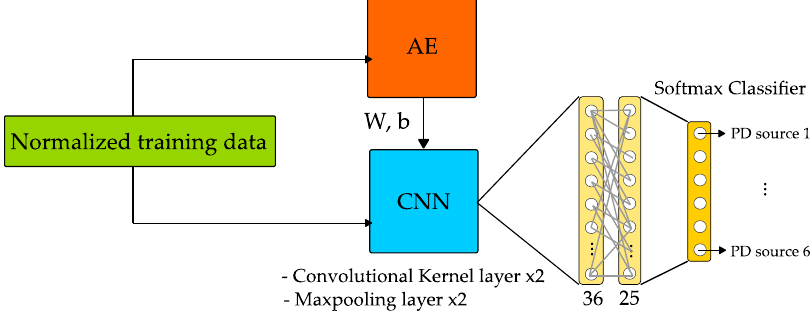
Figure 13. CNN structure combined with an autoencoder (AE) model proposed by [28].